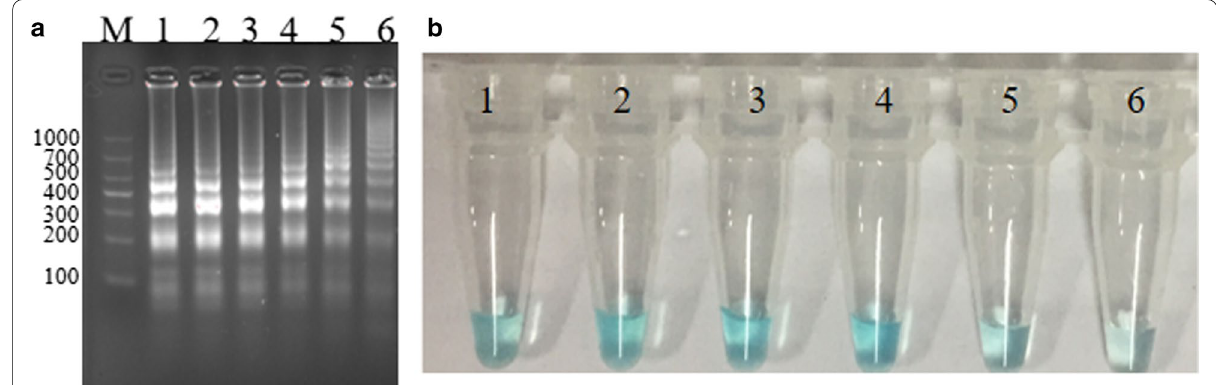
Fig. 4 Temperature screening. 2.5 pg S. agalactiae strain ATCC12386 genome in MCDA reaction were respectively amplified at six different temperatures varing from 60 to 65 °C with 1 °C intervals. Then, we evaluate the amplification efficiency of the S. agalactiae- MCDA assay by using two methods, including Malachite Green and Agarose gel